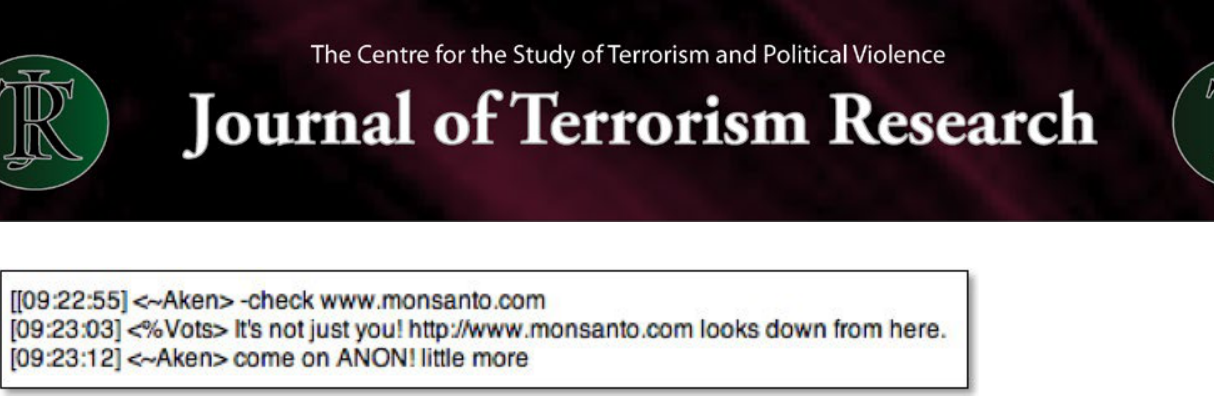
Figure 9: example of Op Green Rights IRC dialog